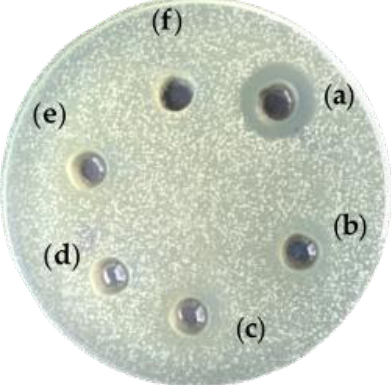
Figure 6. Antimicrobial activity of EPS from B. licheniformis 24 against Vibrio cholerae non-O1 strain. ( a ) EPS1, 10 mg/mL; ( b ) EPS1, 5 mg/mL; ( c ) EPS1, 1 mg/mL; ( d ) EPS2, 10 mg/mL; ( e ) EPS2, 5 mg/mL; ( f ) EPS2, 1 mg/mL.